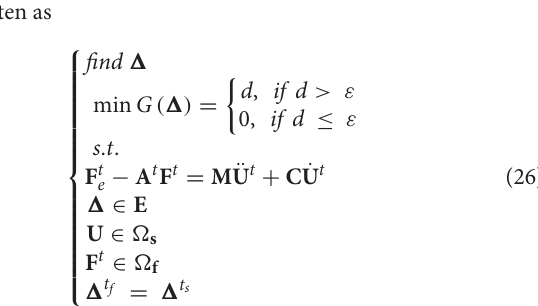
Frontiers in Built Environment |